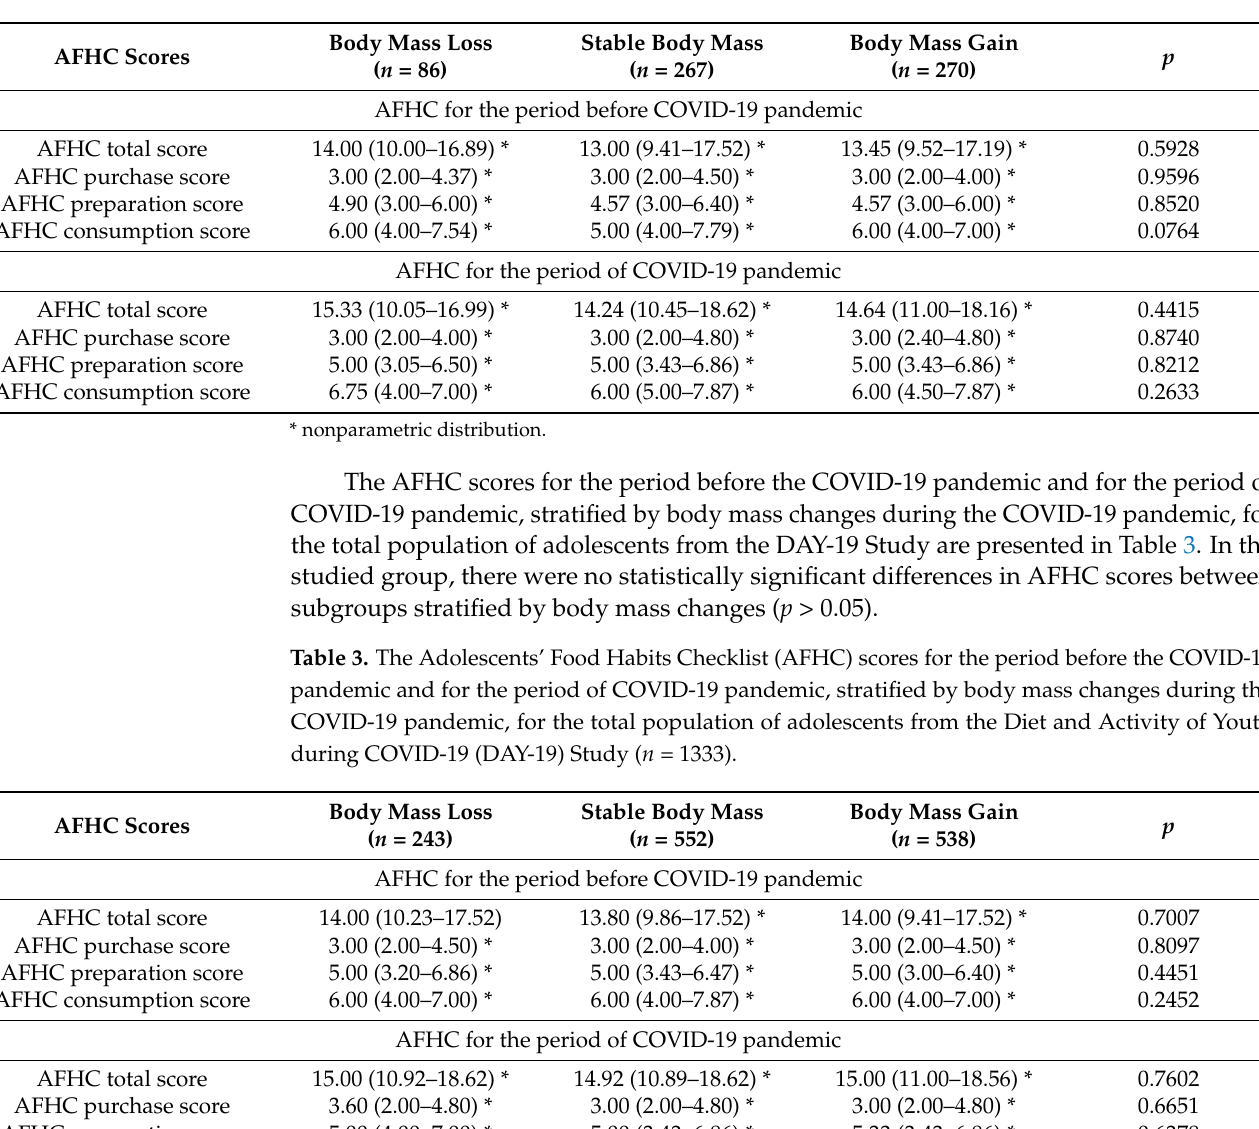
Table 2. The Adolescents’ Food Habits Checklist (AFHC) scores for the period before the COVID-19 pandemic and for the period of COVID-19 pandemic, stratified by body mass changes during the COVID-19 pandemic, for the population of male adolescents from the Diet and Activity of Youth during COVID-19 (DAY-19) Study ( n = 623).